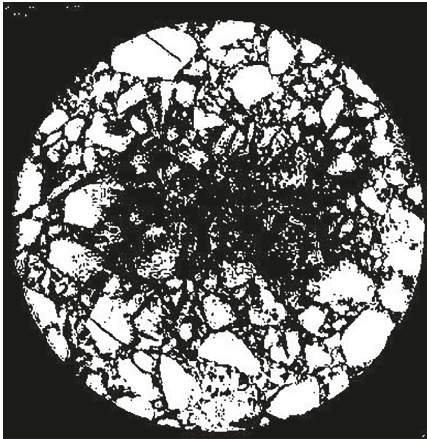
Figure 2: Image of gray level from 189 to